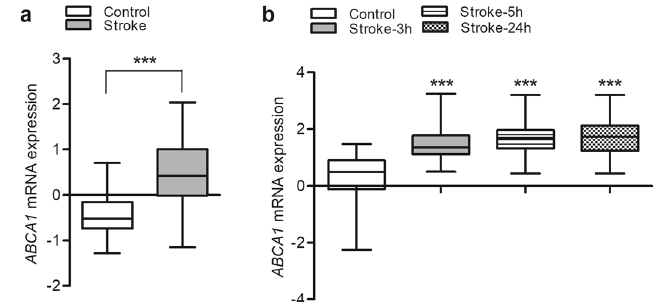
Figure 6. Upregulated ABCA1 mRNA expression in stroke-patient blood. Human blood mRNA expression levels of ABCA1 obtained from the Gene Expression Omnibus datasets GSE16561 and GSE58294 are shown in ( a ) and ( b ), respectively. Data are shown as box-and-whisker plots (from minimum to maximum). Statistical analyses were performed using t-tests ( a , *** = p < 0.001) or a one-way analysis of variance followed by Dunnett’s multiple comparison test anchored to control data ( b , *** = p < 0.001). Abbreviations: Abca1, ATP-binding cassette subfamily A member 1; mRNA, messenger ribonucleic